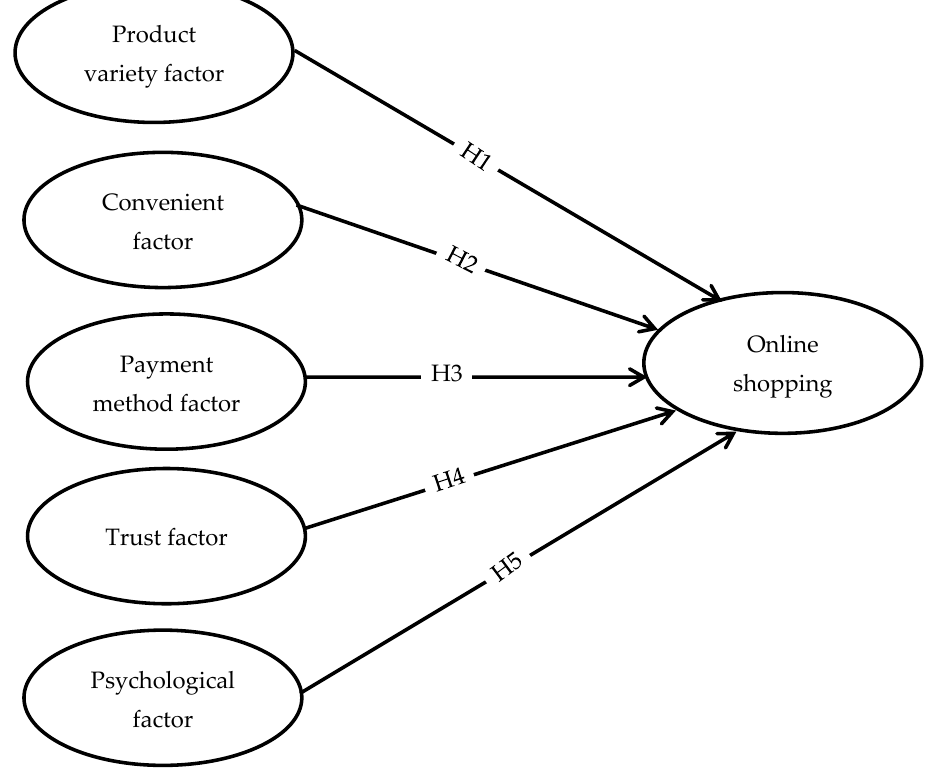
Figure 1. The theoretical research model.